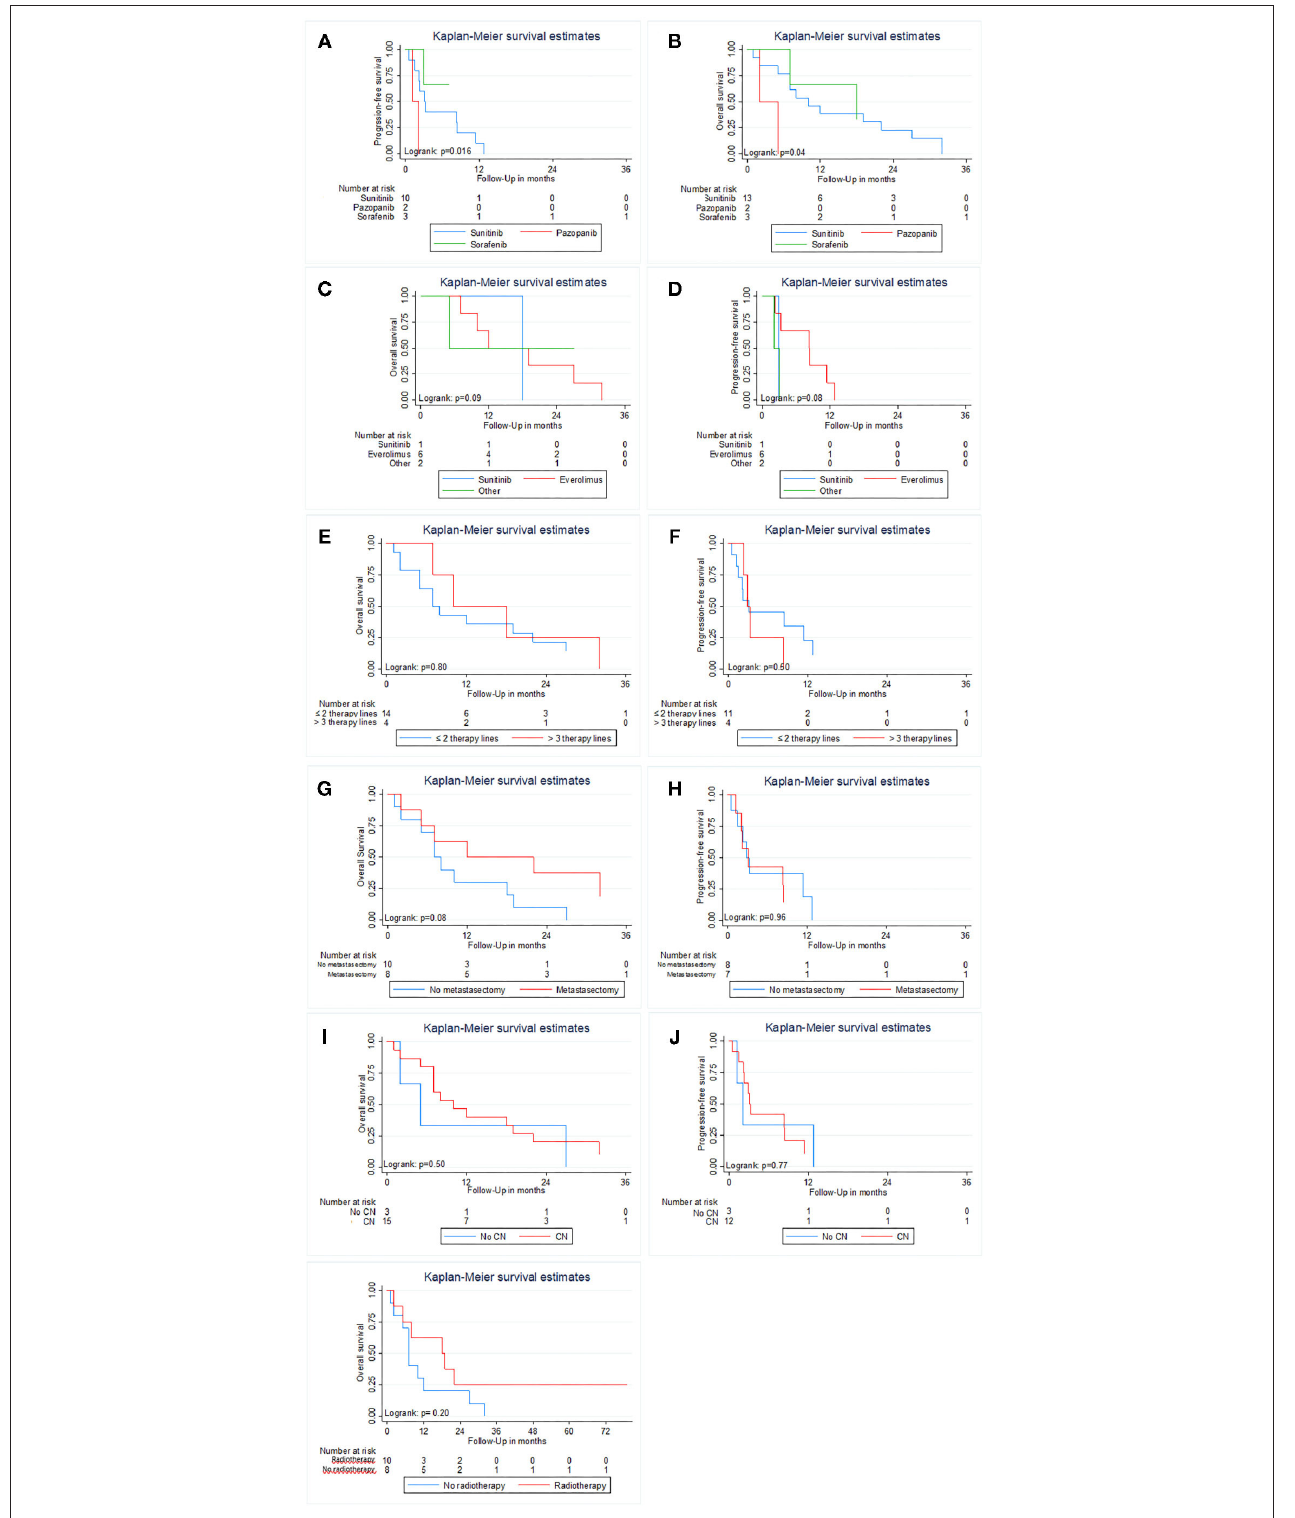
FIGURE 3 | Kaplan Meier estimates of Overall and Progression-free survival in patients with sarcomatoid features in histology stratified by first-line therapy (A,B) ; MSKCC prognostic risk score (C,D) , Gender (E,F) , performed metastasectomy (G,H) , cytoreductive nephrectomy (I,J) and additional radiotherapy (K) . Progression-free survival was not analyzed for additional radiotherapy due to its main use after progression of the disease.